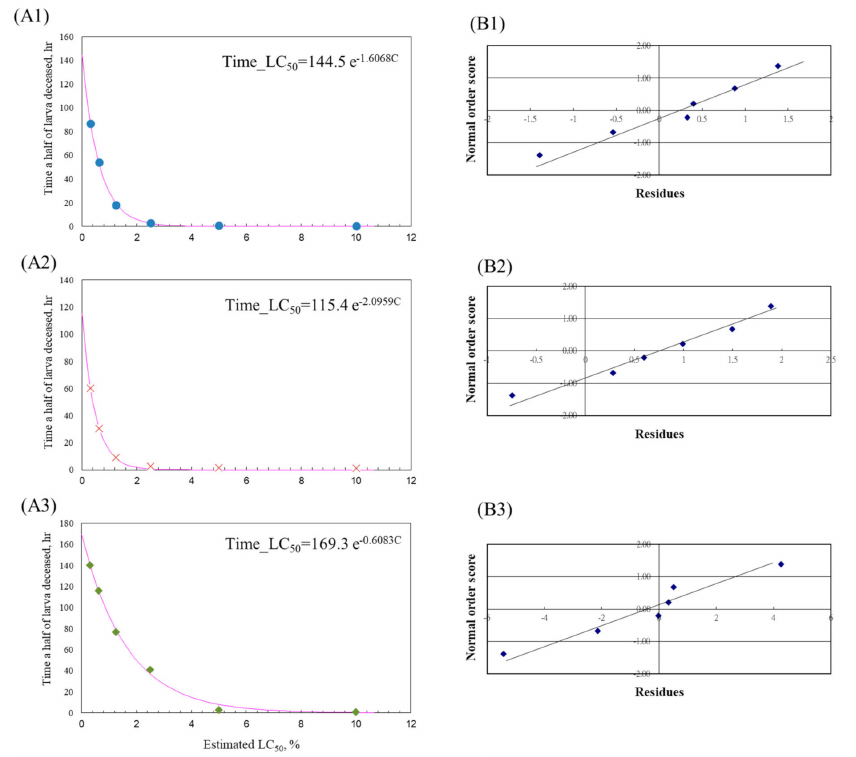
Figure 8. Plots of time a half of larva mortality versus the estimated LC 50 ( A1–A3 ) and residual Normal plots ( B1–B3 ) for SCLs of date, pomelo, and guava, respectively.